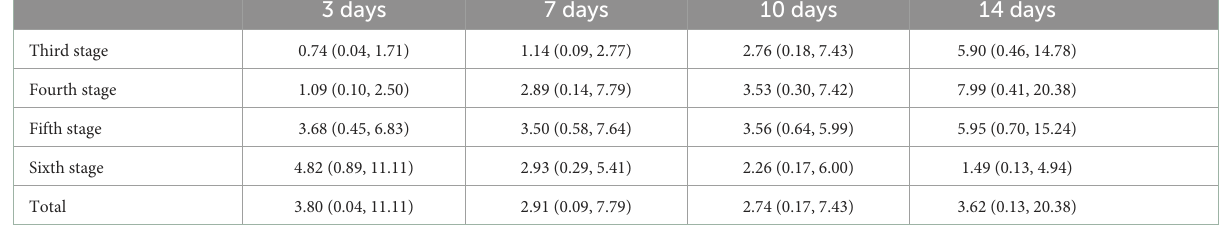
TABLE 2 Conversion rate (%) during each incubation